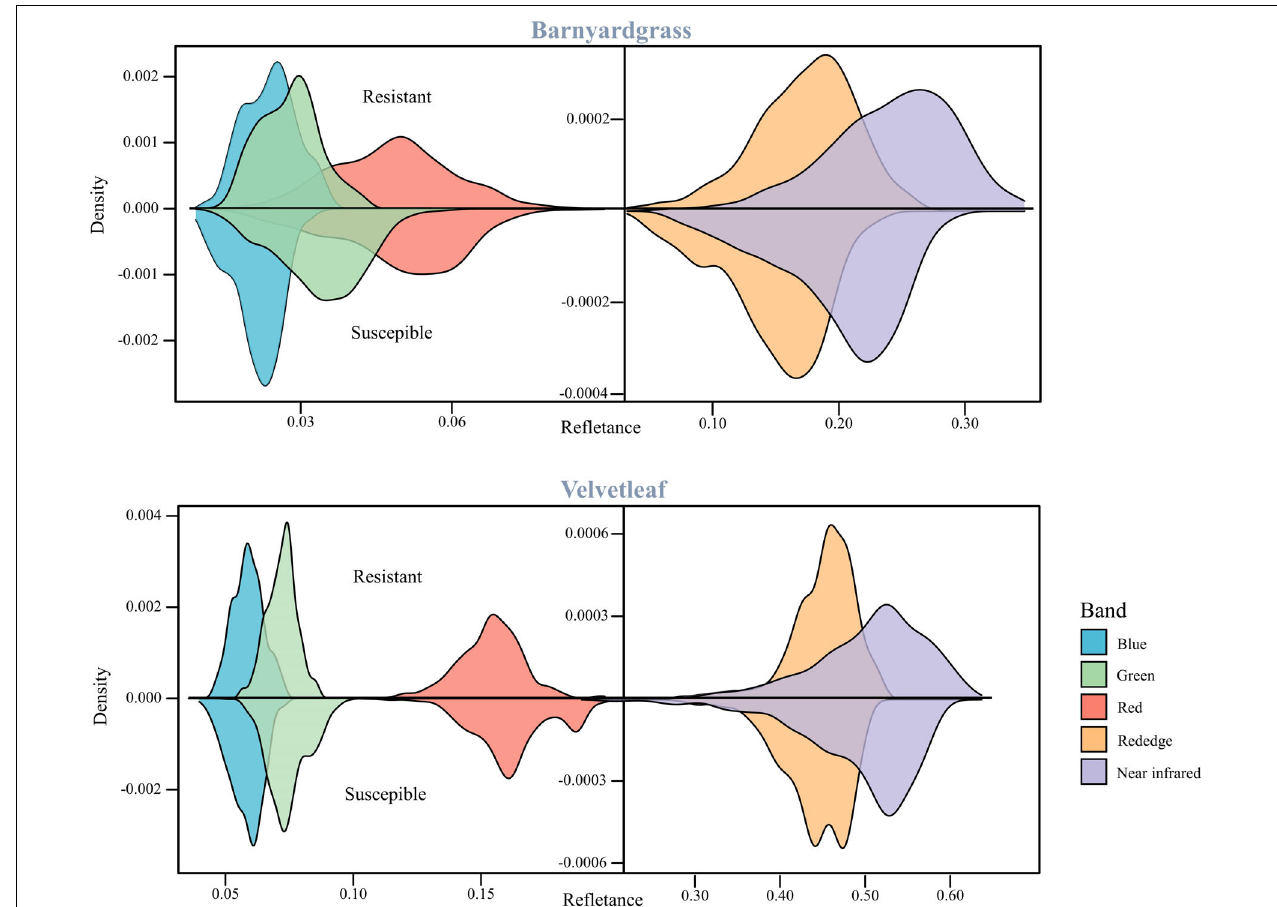
FIGURE 3 | Reflectance density maps of two weed resistant and susceptible biotypes.